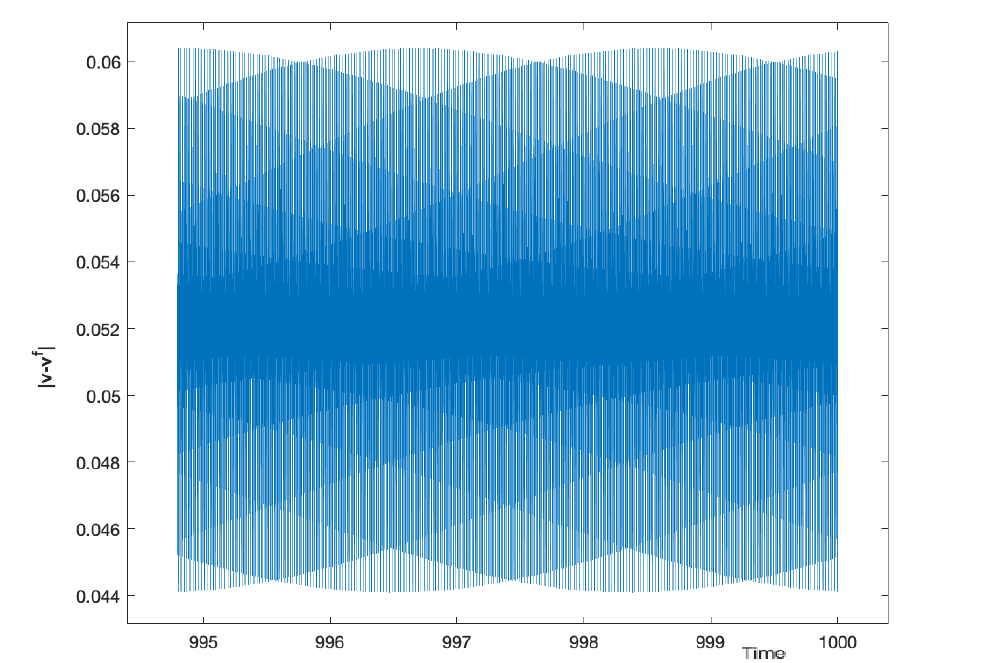
Figure 3. | v − v f | for a Reynold’s number of